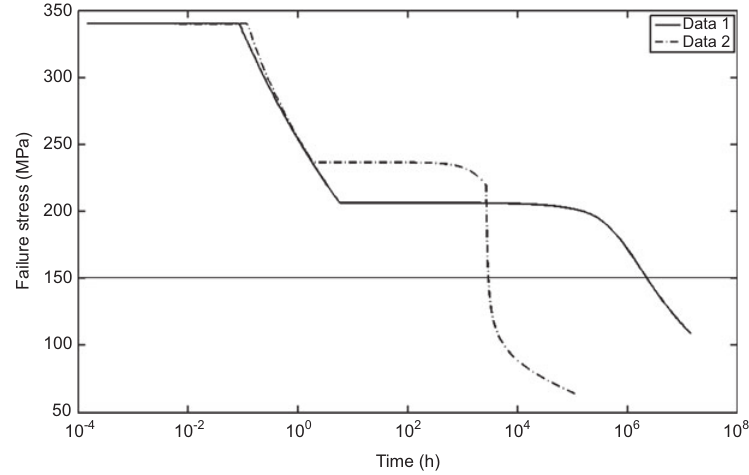
Figure 2 Failure stress as a function of time (fatigue and creep